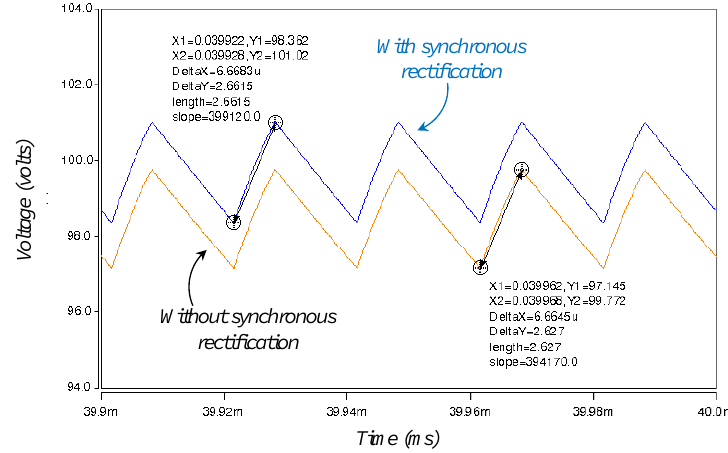
Figure 14. Zoom in the output voltage.